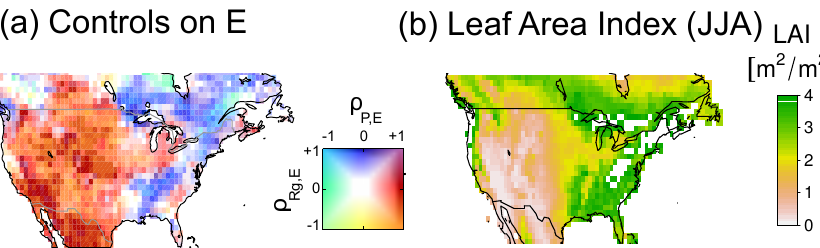
Figure 12. (a) Land evaporation regime (blue for wet regime, red for transitional regime): multi-model analysis of controls on yearly land evaporation from Teuling et al. (2009). Correlation between yearly evaporation and global radiation ( ρ R and precipitation ( ρ P,E ), for the period 1986–1995. Each color corresponds to a unique combination of ρ R (JJA) leaf area index [m 2 m − 2 ] over the period 1995–2007, from Stöckli et al.